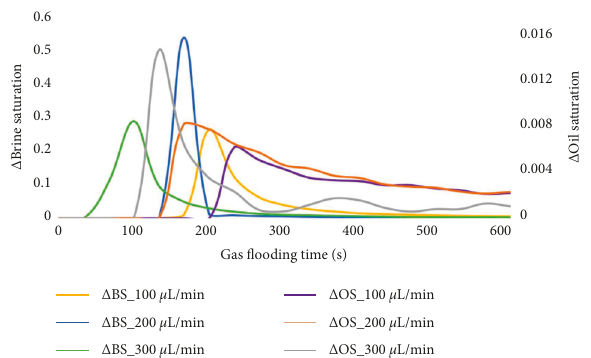
Figure 11: The variation of TSD and gas saturation of various gas injection rates at diverse gas injection